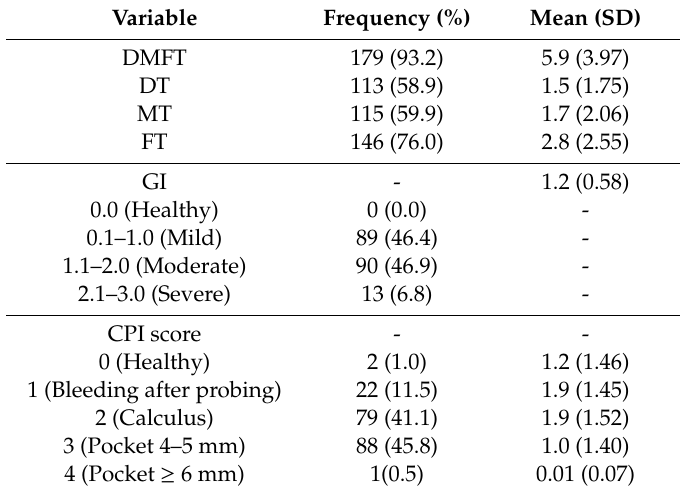
Table 2. Dental caries experience, gingival health and periodontal health.